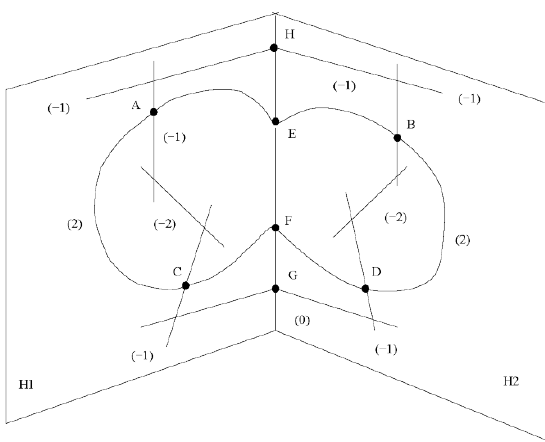
Figure 7. The planes H